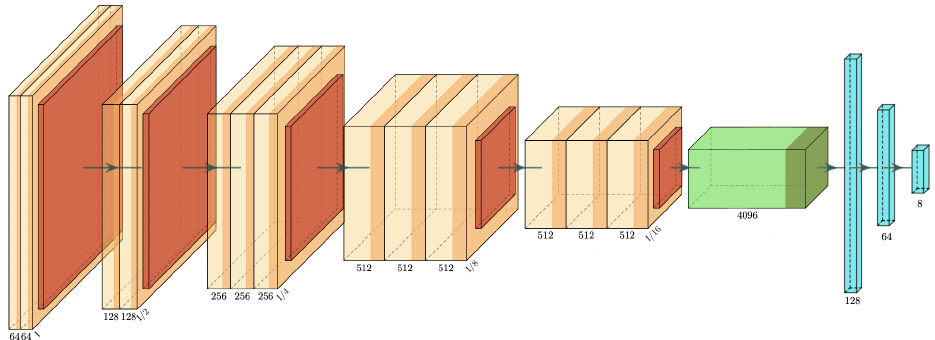
Figure 6. VGG-16 structure: the orange blocks represent the convolutional layers, the red ones are the pooling layers. The green block represents the flatten layer. Finally the blue blocks represents the fully connected